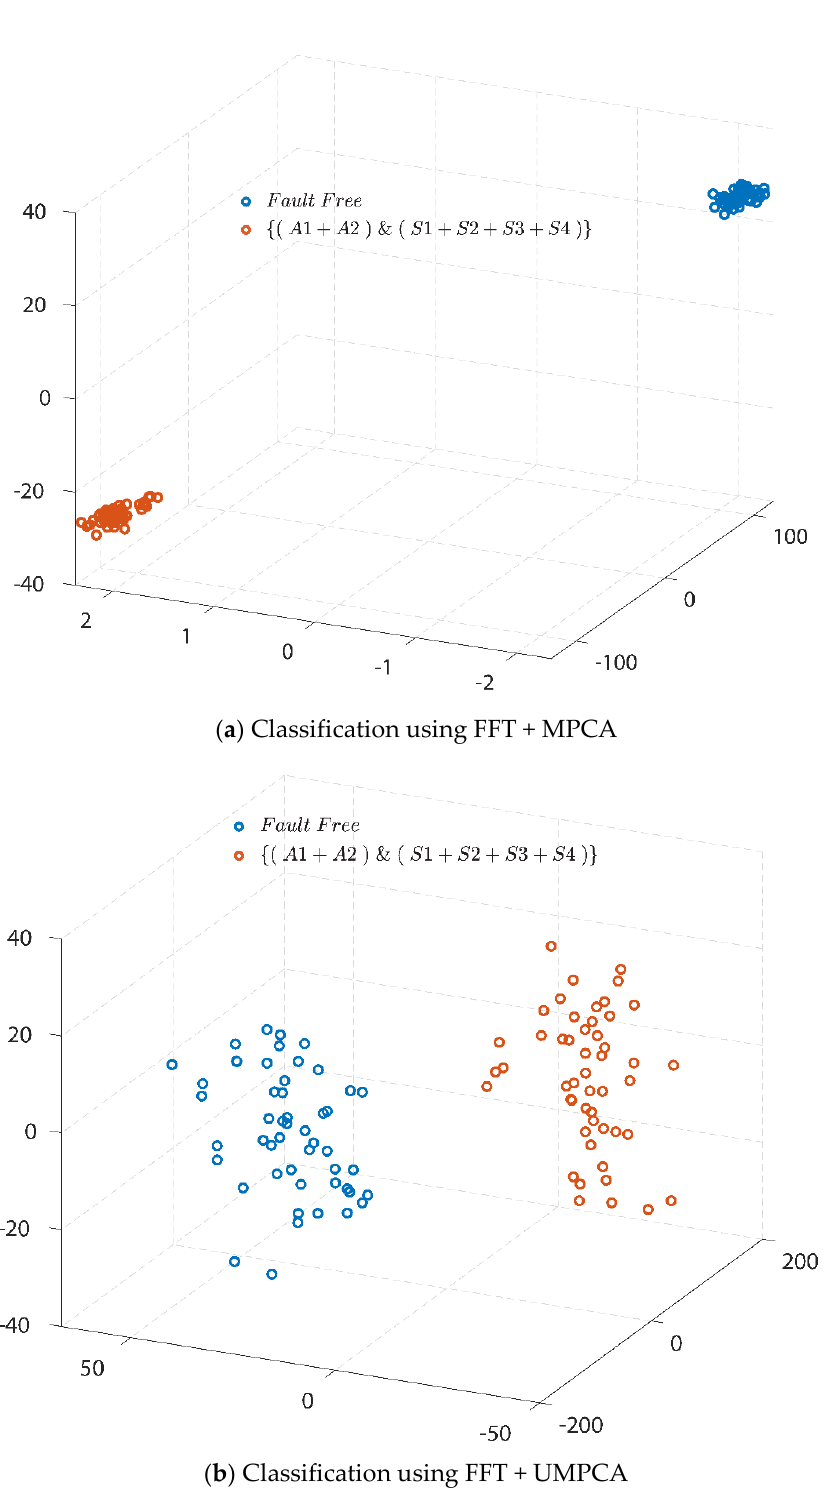
Figure 19. Three-dimensional space visualization performance for fault classification for wind turbines subjected to two actuator and four sensor faults under AWGN noises, using ( a ) FFT + MPCA and ( b ) FFT + UMPCA, respectively.